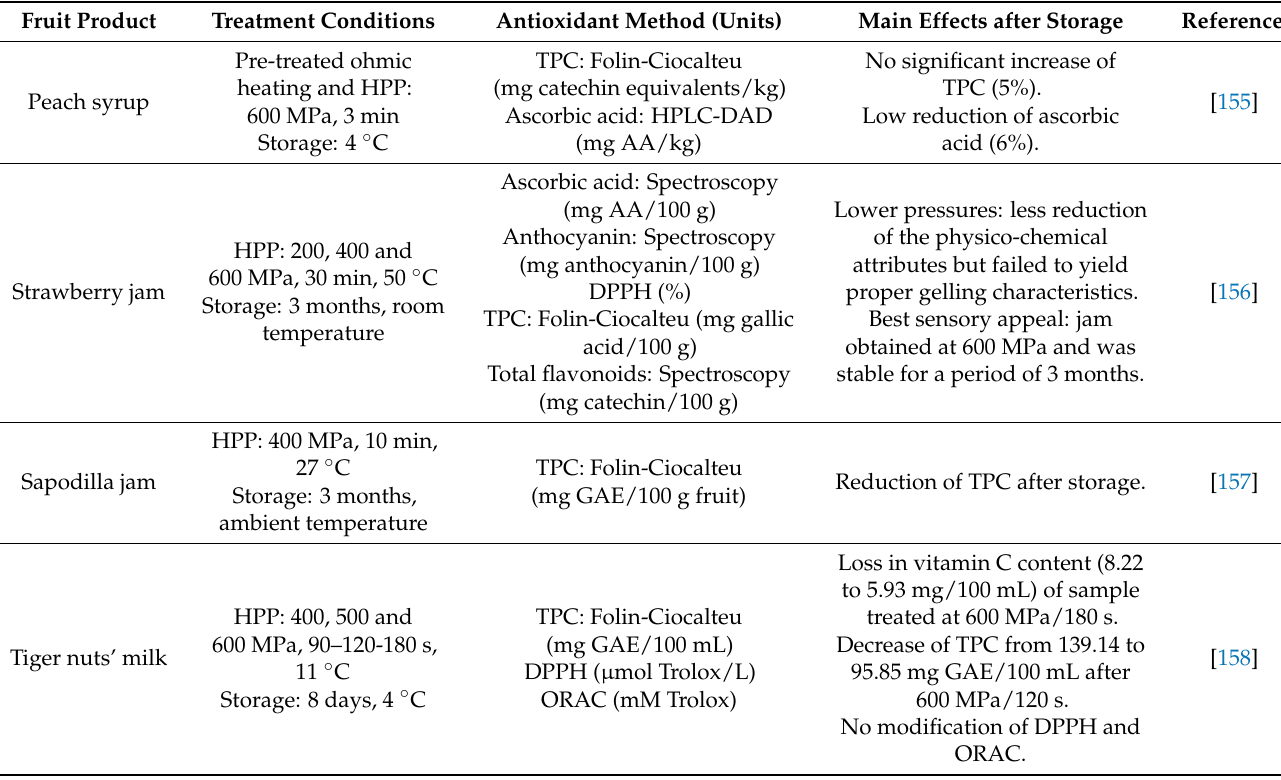
Table 3. Effect of HPP treatment and storage on the antioxidant capacity of different beverages and fruit-based products. Fruit